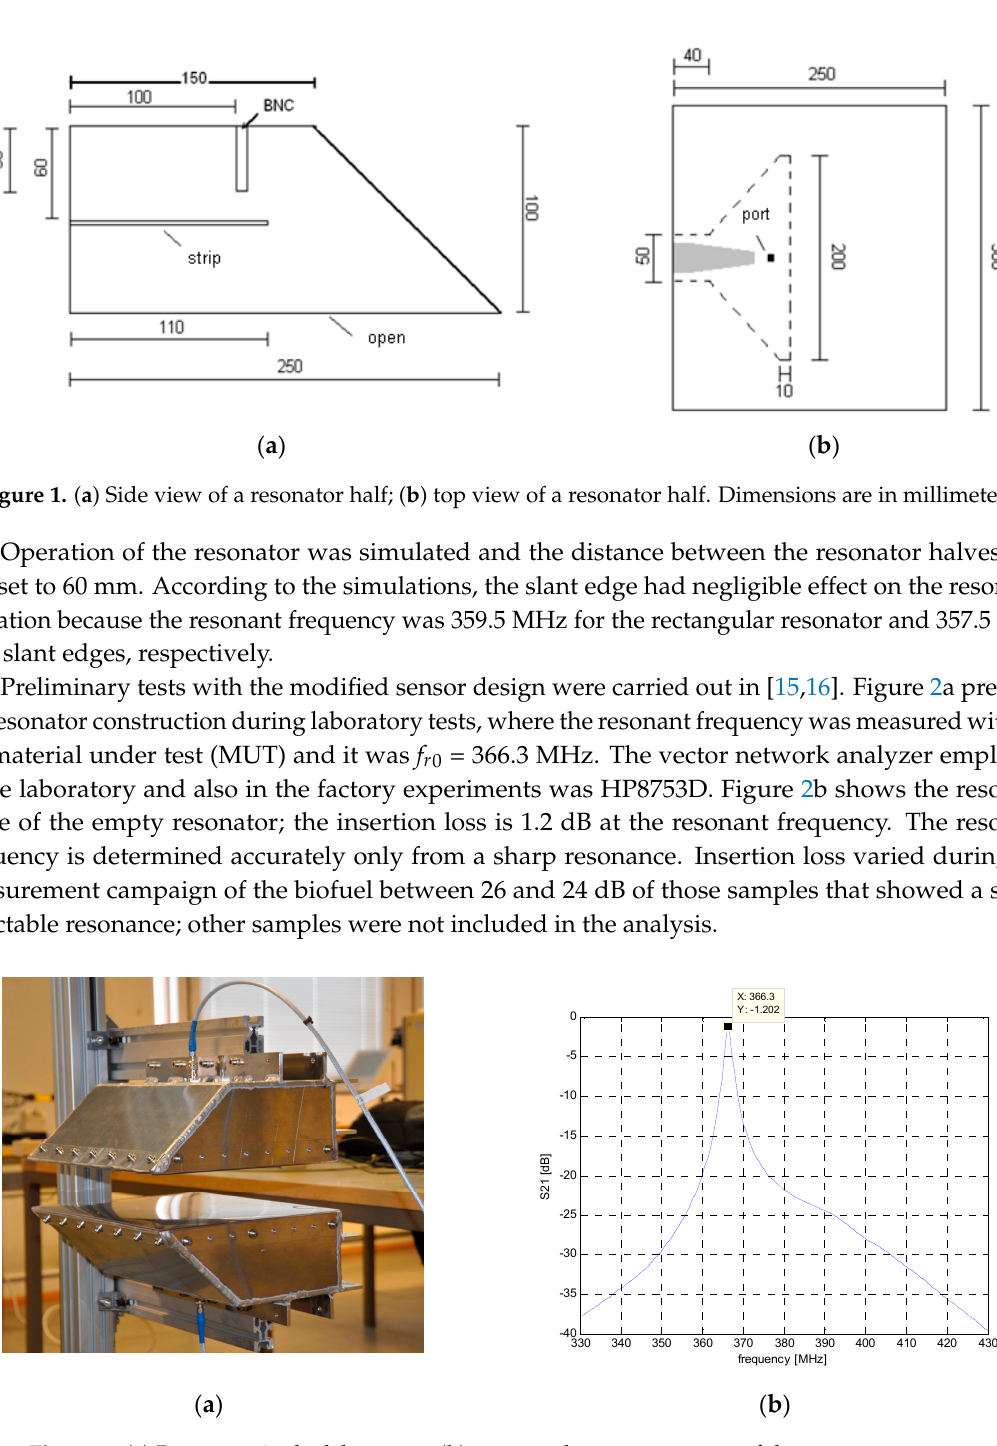
Figure 2. ( a ) Resonator in the laboratory; ( b ) measured resonance curve of the empty resonator.